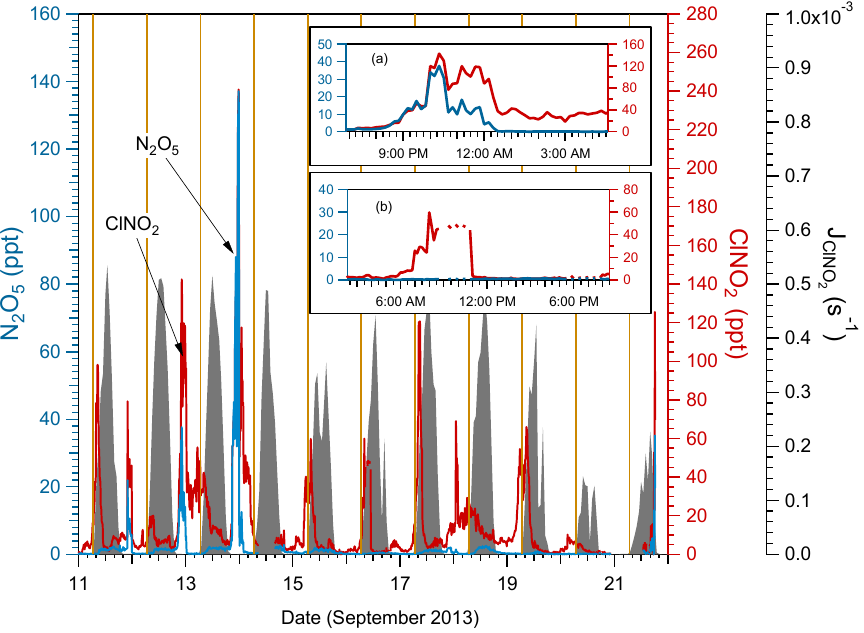
Figure 2. Time series of 10-min average ClNO 2 and N 2 O 5 concentrations at the Conroe, Texas site from 11–21 September. Two distinct patterns were observed with respect to N 2 O 5 and ClNO 2 . Inset ( a ) shows a time period (9/13) when ClNO 2 and N 2 O 5 concentrations correlated. Inset ( b ) shows a time period (9/16) when little N 2 O 5 concentrations remained below the detection limit despite elevated ClNO 2 concentrations. A time series of the ClNO 2 photolysis rate is shown in grey, and vertical lines represent